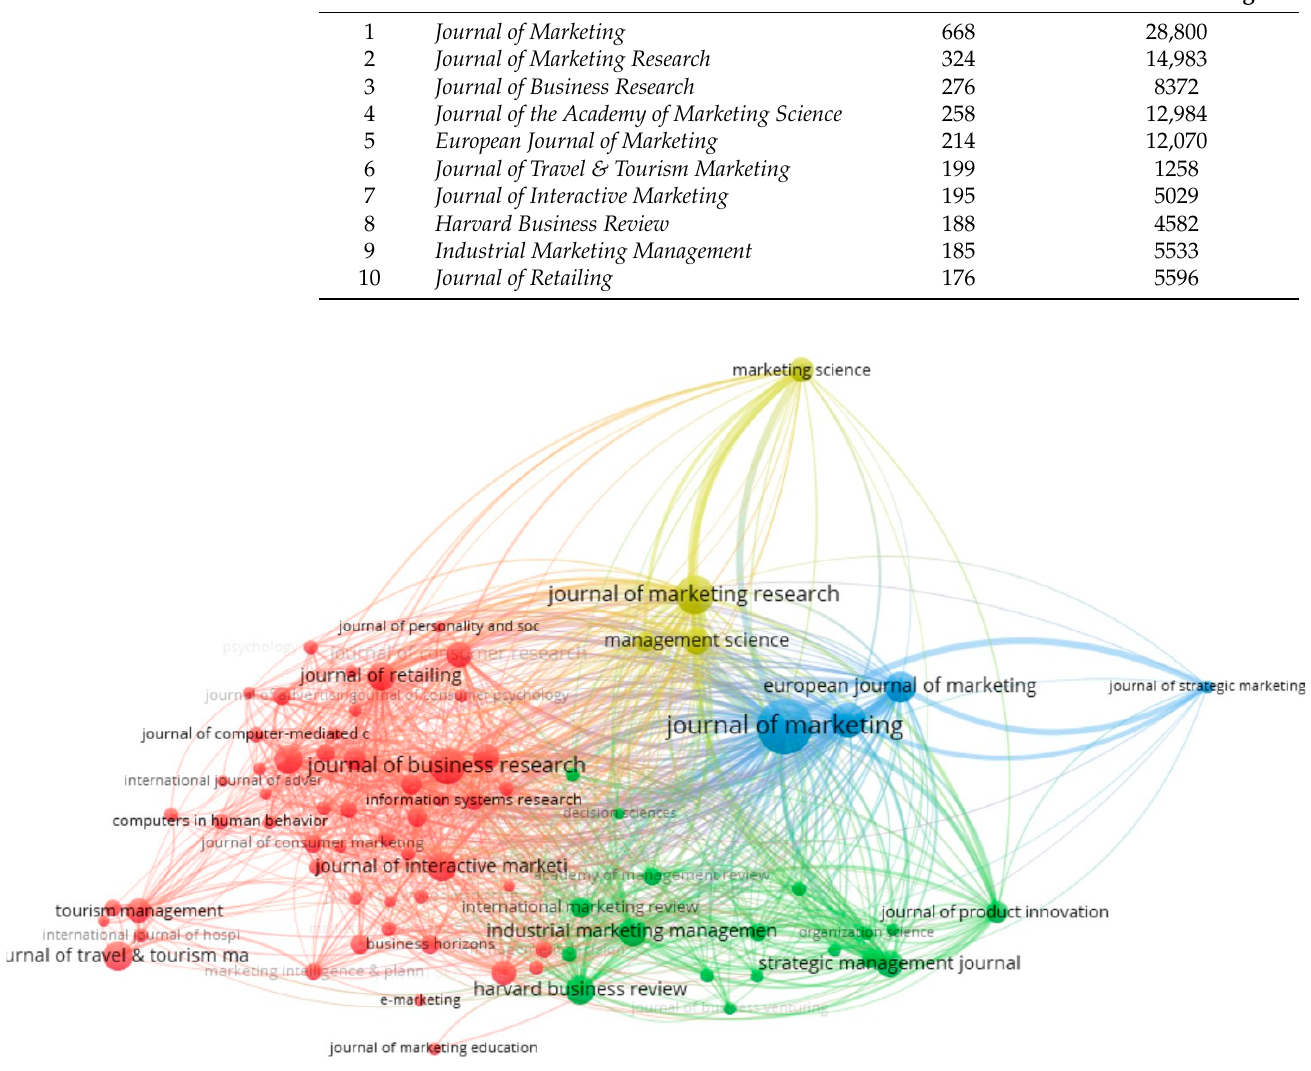
Figure 4. Co-citation of the top ten journals.